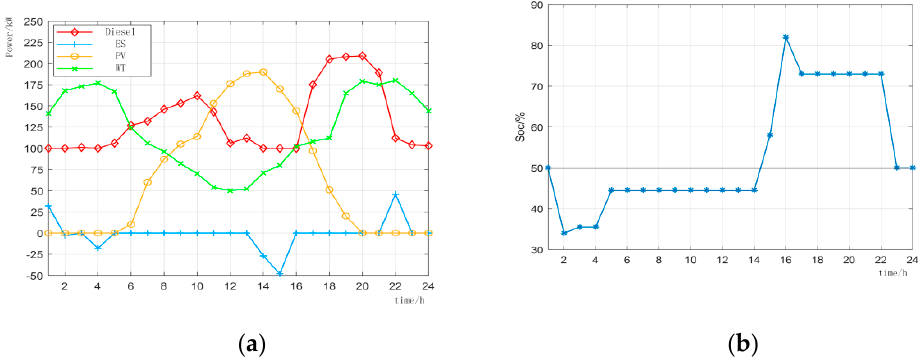
Figure 19. Power curve of each power generation ( a ) and SOC curve of energy storage system ( b